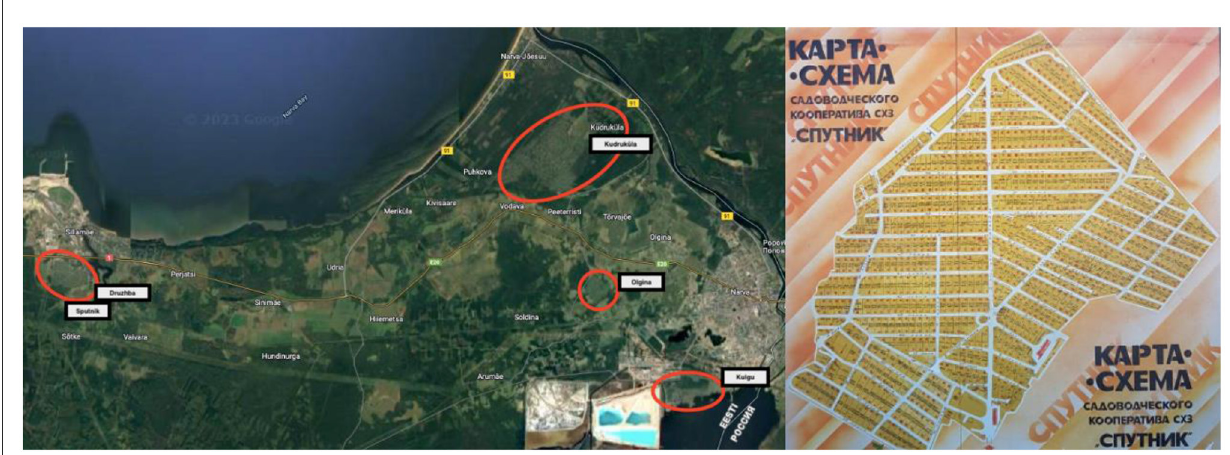
FIGURE1 The satellite photo (left) of Ida-Viru region between Sillamäe (on the left, right at the Baltic Sea) and Narva (on the right, at the Russian border) with the marked areas of dacha cooperatives (Sputnik, Druzhba) or their sites (Kudruküla, Olgina, Kulgu). A map (right) of the Sputnik dacha cooperative with over 1,100 garden plots.